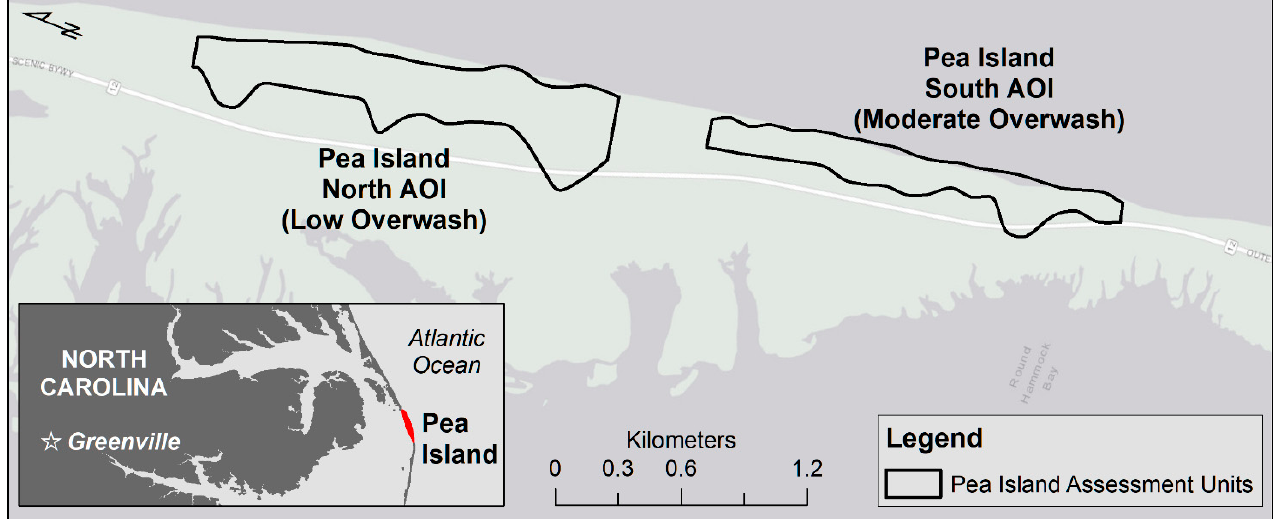
Figure 1. Location map of Pea Island study site and assessment units (areas of interest).